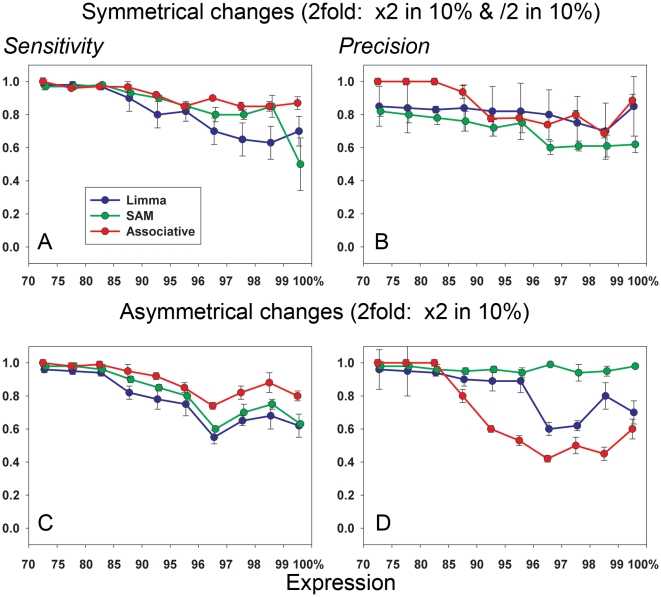
Comparison of different methods for gene expression analysis.Sensitivity/Precision of Limma, SAM and Associative analyses. The 2-step normalization procedure was used in all cases. The restrictions were Fd/Fa/Em = 2/1.5/20. A) Sensitivity and B) Precision for symmetrical changes in gene expression (2-fold increases and 2-fold decreases in gene expressions were equally presented). C) Sensitivity and D) Precision for asymmetric changes in gene expression (2-fold increases in 10% portion of gene expressions). Axes designation is the same as in Figure 4.